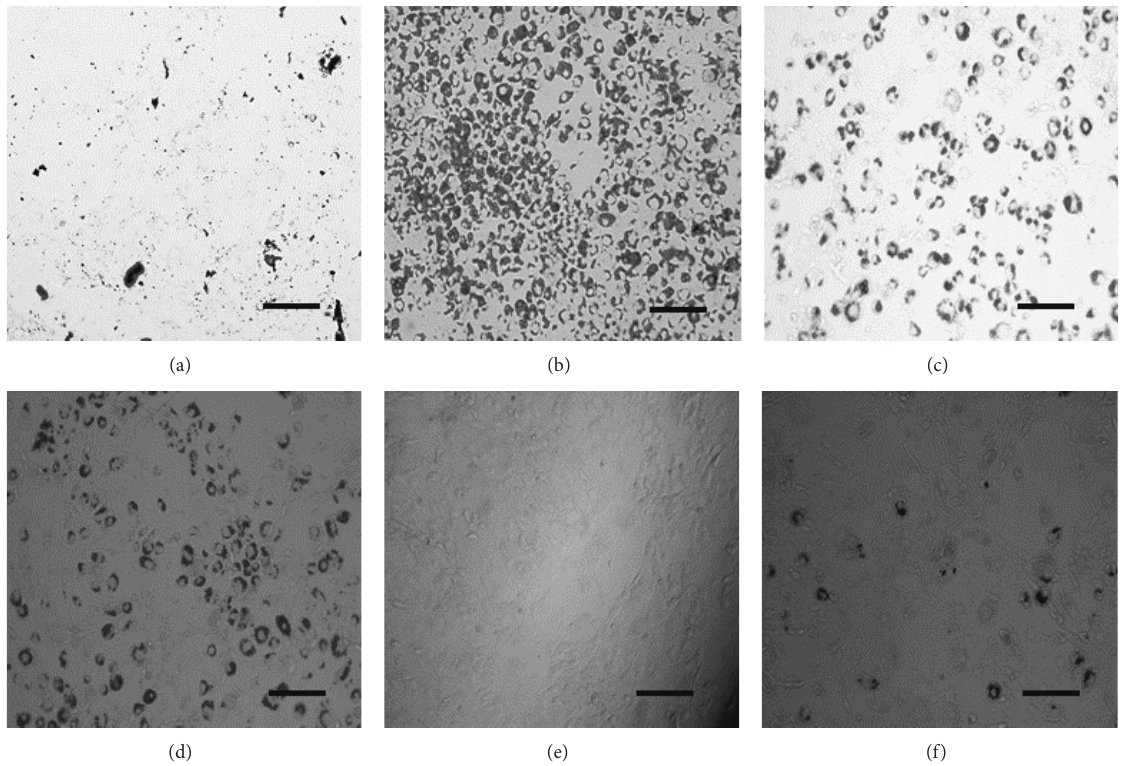
Figure 4: Photographs of 3T3-L1 adipocytes after Oil Red O staining. (a) Normal (control); (b) induction (hormone mixture); (c) induction (hormone mixture) + 12.5 𝜇 M of MBAB; (d) induction (hormone mixture) + 25 𝜇 M of MBAB; (e) induction (hormone mixture) + 50 𝜇 M of MBAB; (f) induction (hormone mixture) + 50 𝜇 M of resveratrol. Scale bar = 50 𝜇 m.